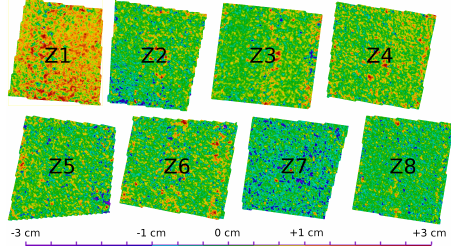
Figure 10: Dataset 2014: comparison between the mesh constructed from the terrestrial images, and the pointcloud derived from the UAV acquisition. Except for Z1, on the edge of the survey zone, these ground control zones present results in accordance with the 1cm on the altitude accuracy targeted The difference between both follow a normal distribution with millimetric indicators (Table 3). From these data, the accuracy at one (68,3%) and three sigmas (99,7%) can be estimated. Figure 10 shows the visual repartition of the comparison; it underlines how tricky a punctual check can be. Each little rock or blade of grass are modelized from the terrestrial acquisition, but not with the UAV dataset.